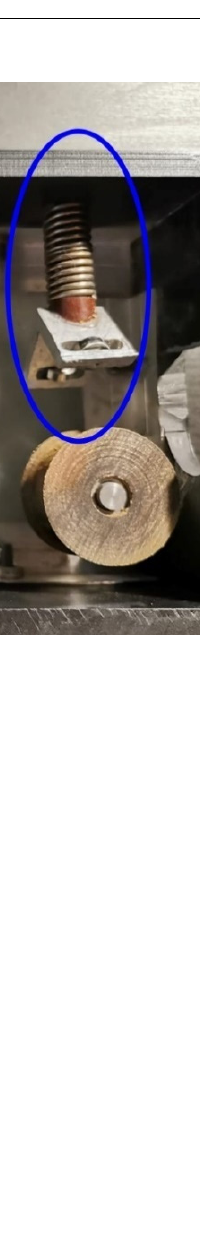
Figure 6. Electrical diagram: 1—17HS4401 motor, 2—Arduino Nano, 3—a4988 driver, 4—LED, 5— switch, 6—Button.